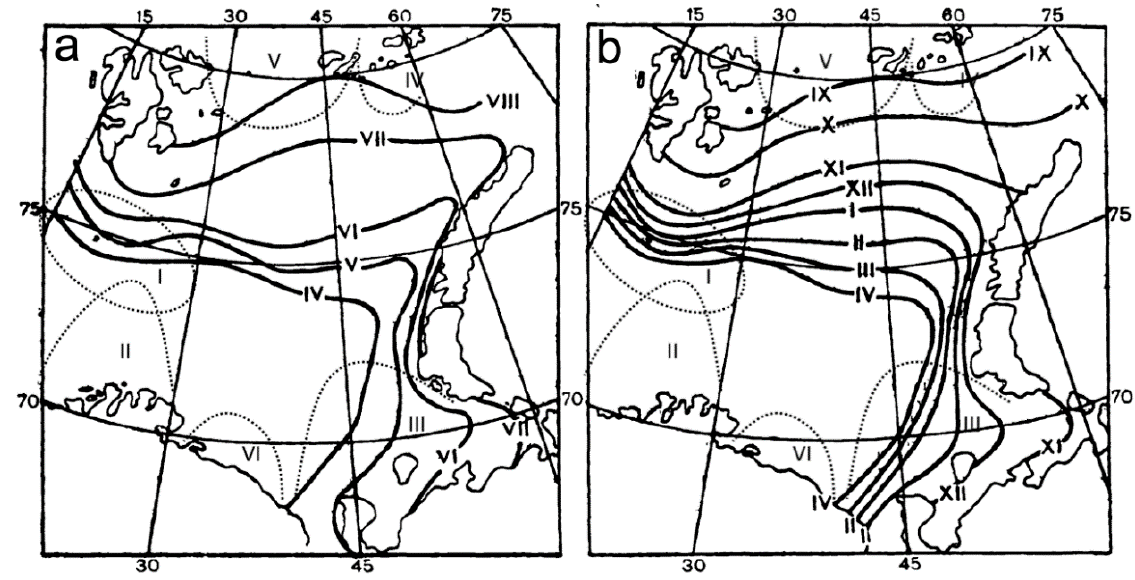
Figure A1. Average long-term position of ice edges in the Barents Sea (( a ), April to August; ( b ) September to April, according to [25]). Dashed lines — area boundaries. Table A1. The calculated regression line, the used statistical test and the significance level.